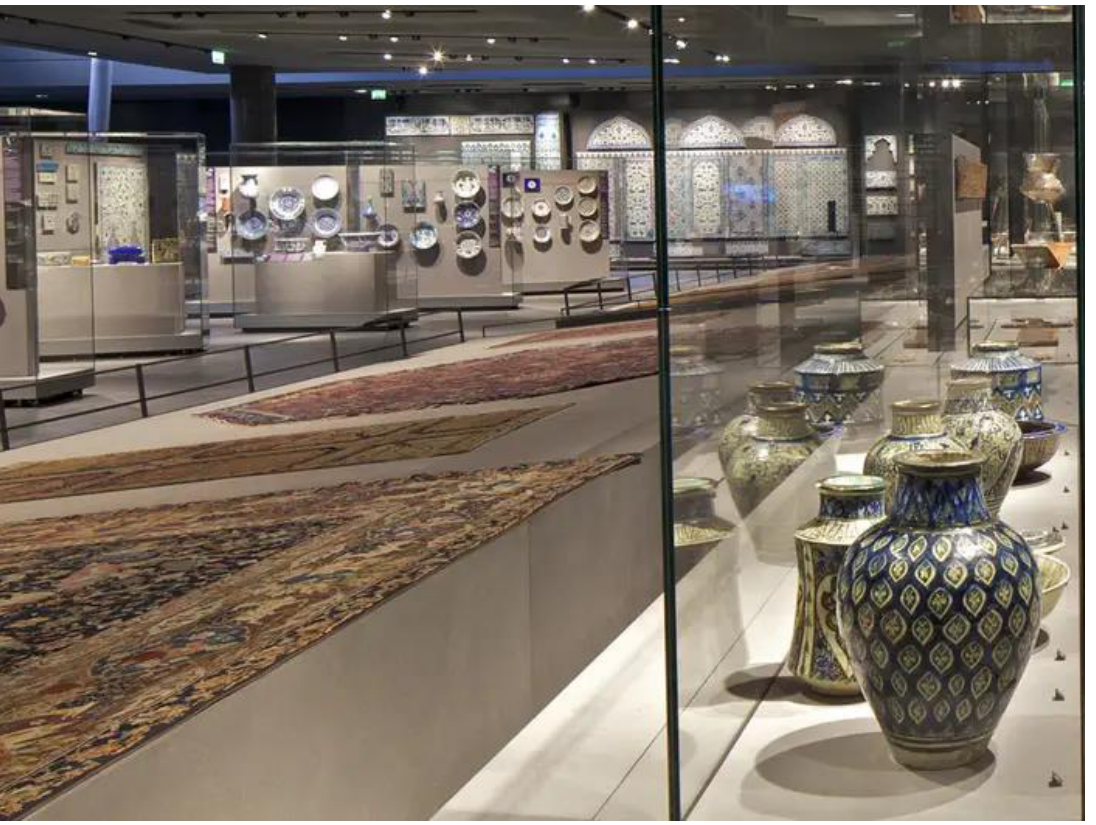
Figure 18. Gallery of Islamic art, Louvre, Paris. Photo: © M. Bellini—R. Ricciotti/Mus é e du